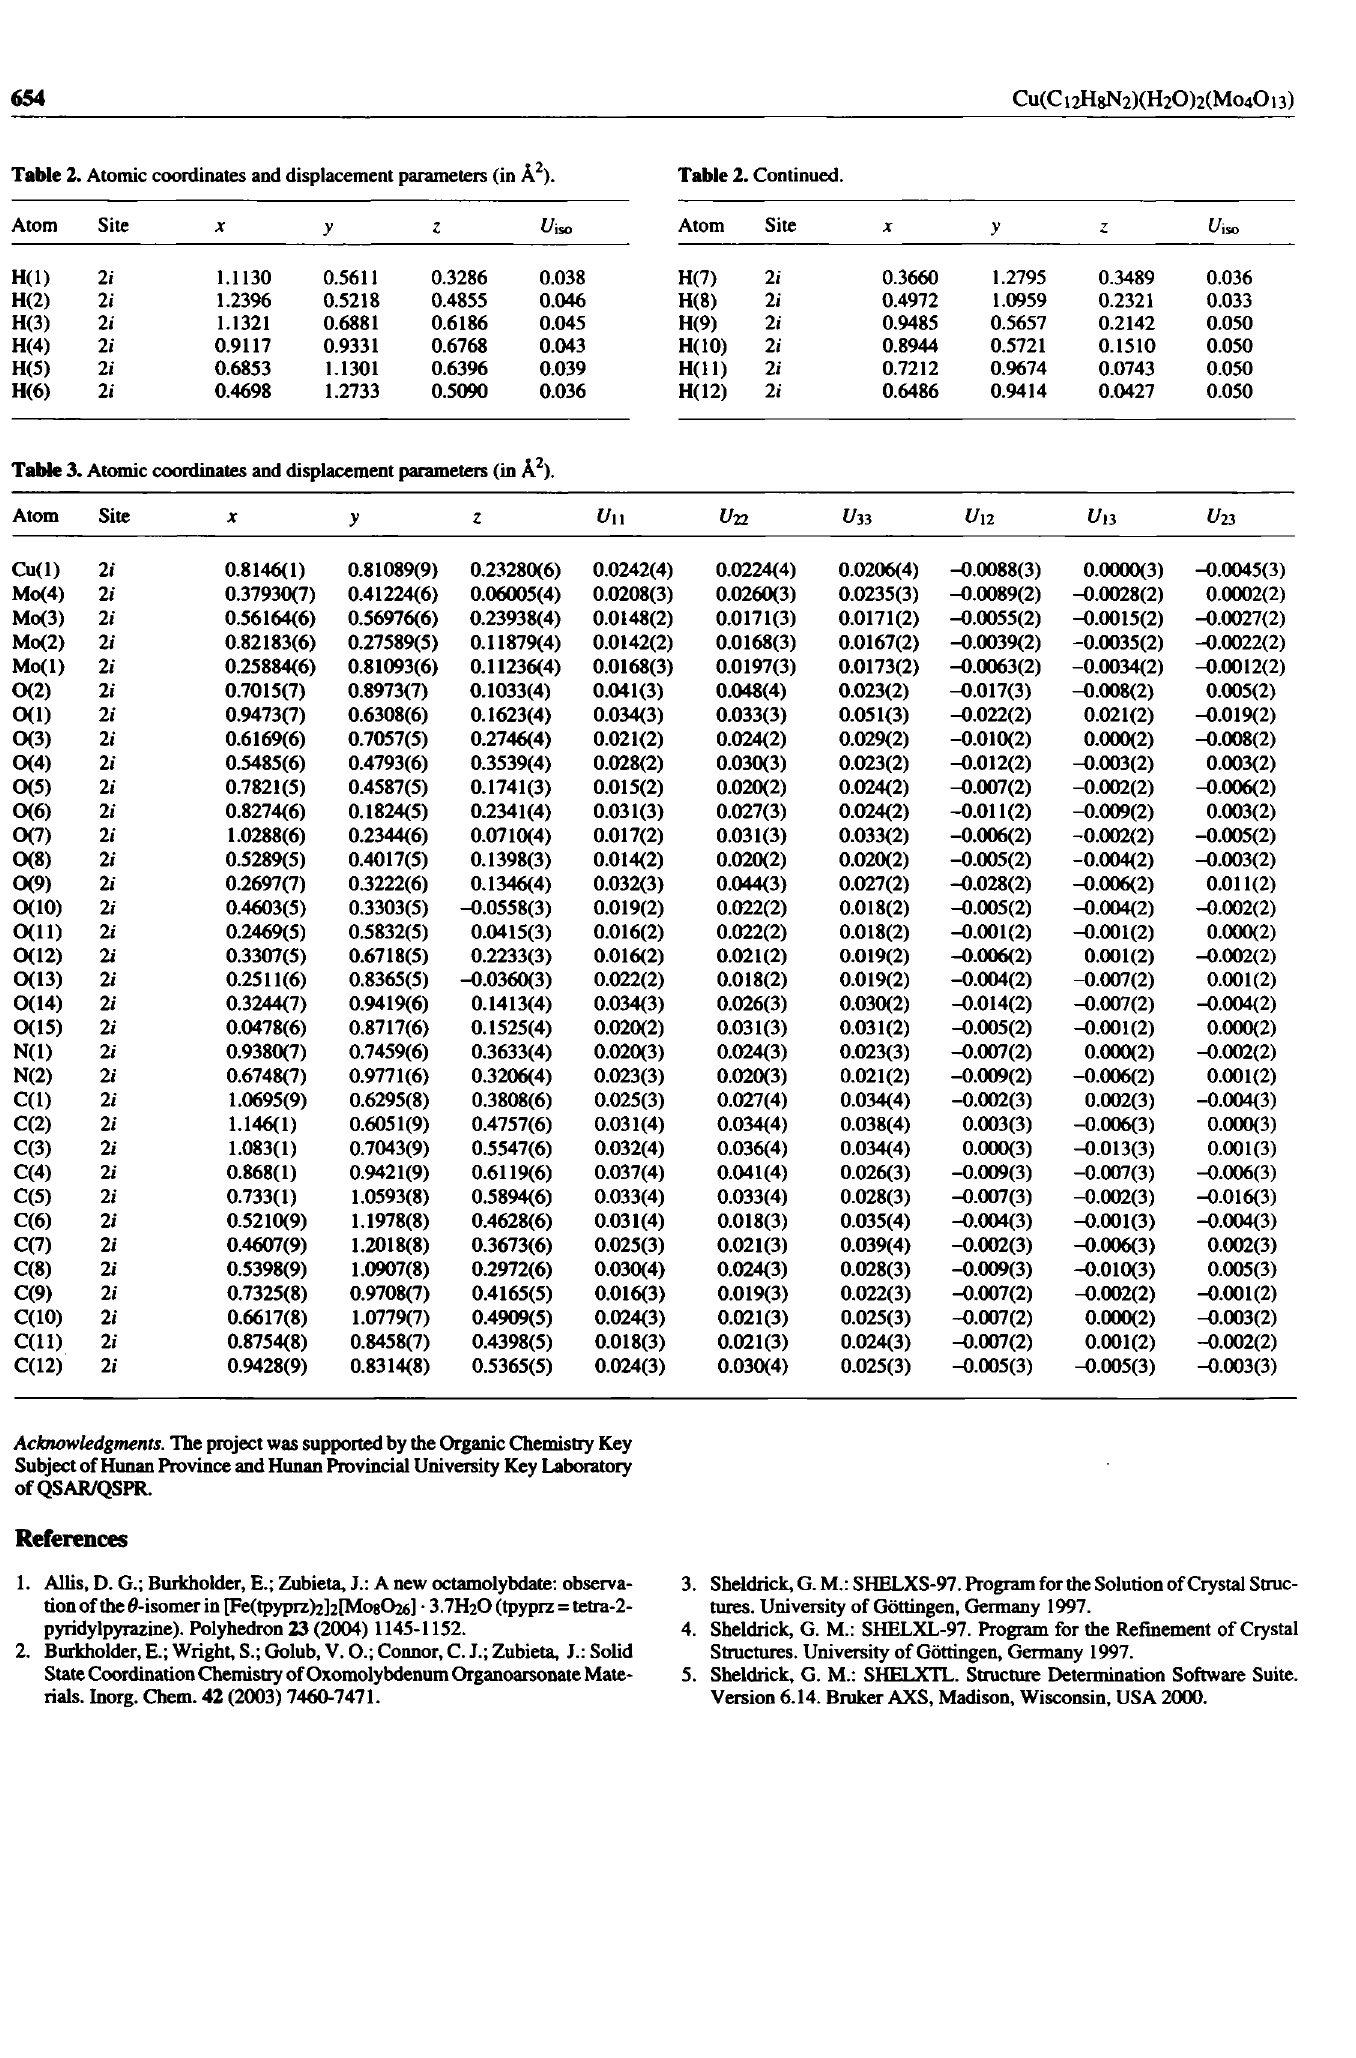
Table 3. Atomic coordinates and displacement parameters (in Â 2